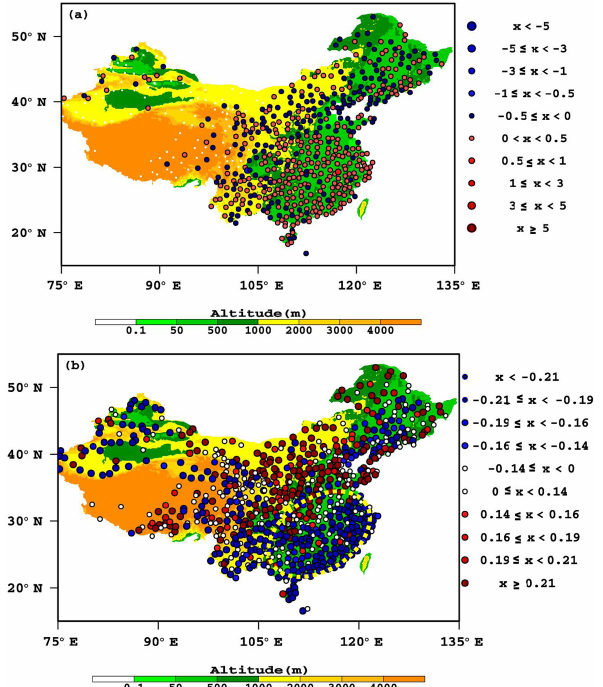
Figure 5. The spatial distributions of (a) trends (day per 10 years) in summertime rainstorm frequency over 1961–2010 in China and (b) correlation coefficients between visibility and low cloud amount in summer of 1961–2010, with the dashed yellow line marking the border of the negative correlation area.